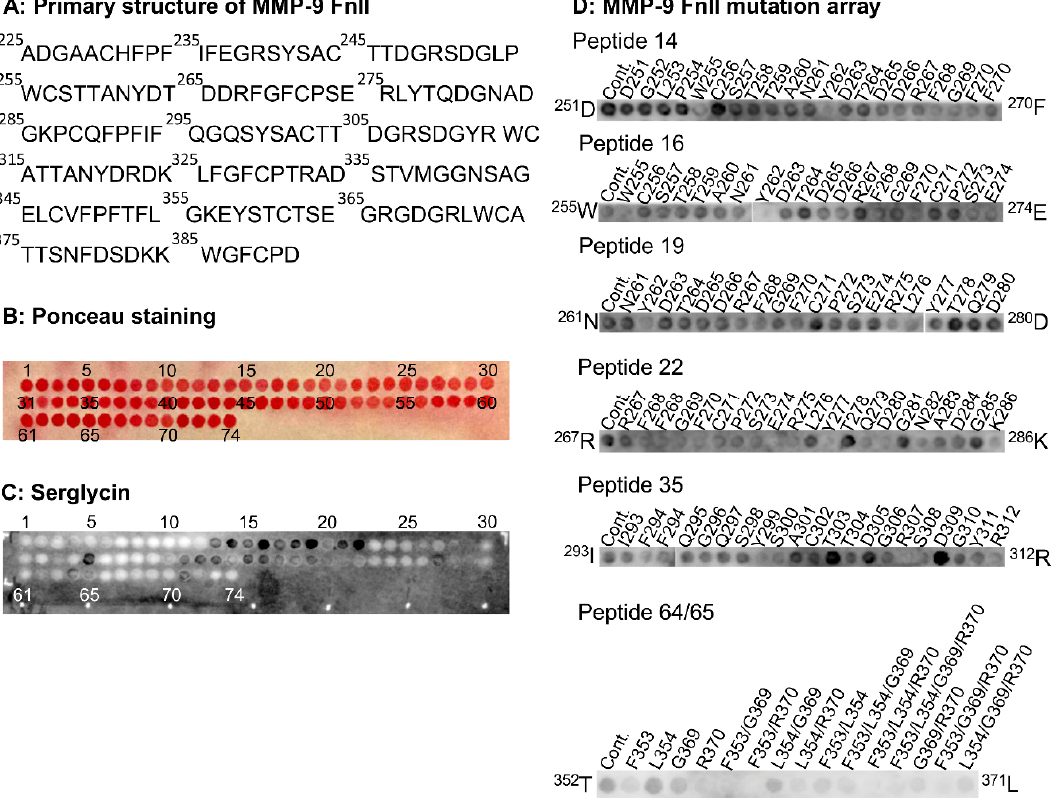
Figure 6. Binding of SG to MMP-9 FnII module peptide arrays. ( A ) Primary structure of the FnII module. ( B ) Ponceau staining of the 20-mer peptides bound on a cellulose membrane, where each